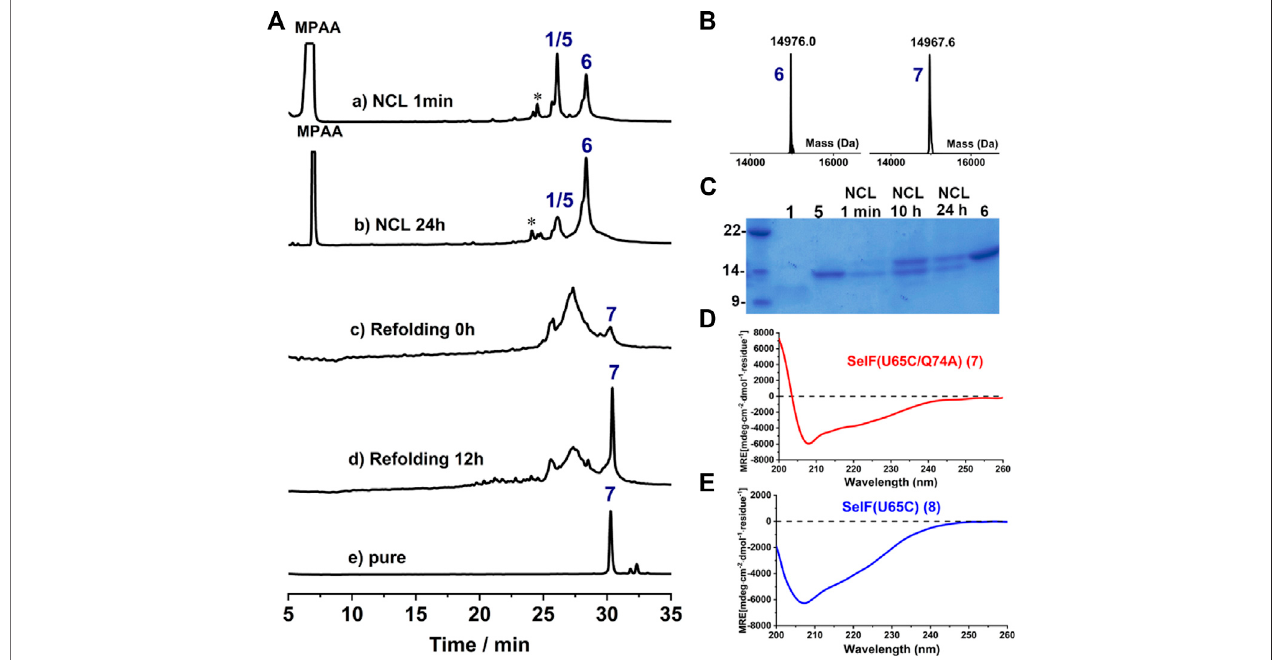
FIGURE4|(A) Analytical HPLCtracesofligation and refolding reaction ofSelF(U65C/Q74A). (B) Massanalysisofligationreaction product 6 and its folded protein 7 , respectively. 6: obsd.mass14,976.0 Da, calcd. mass 14,976.2 Da (average isotopes); 7: obsd. mass 14,967.6 Da, calcd. mass14,968.2 Da (average isotopes). (C) Analytical SDS-PAGE analysis of the ligation reaction. (D,E) CD spectra of the fully synthetic SelF(U65C/Q74A) ( 7 ) (D) and the recombinant SelF (U65C) ( 8 ) (E) .